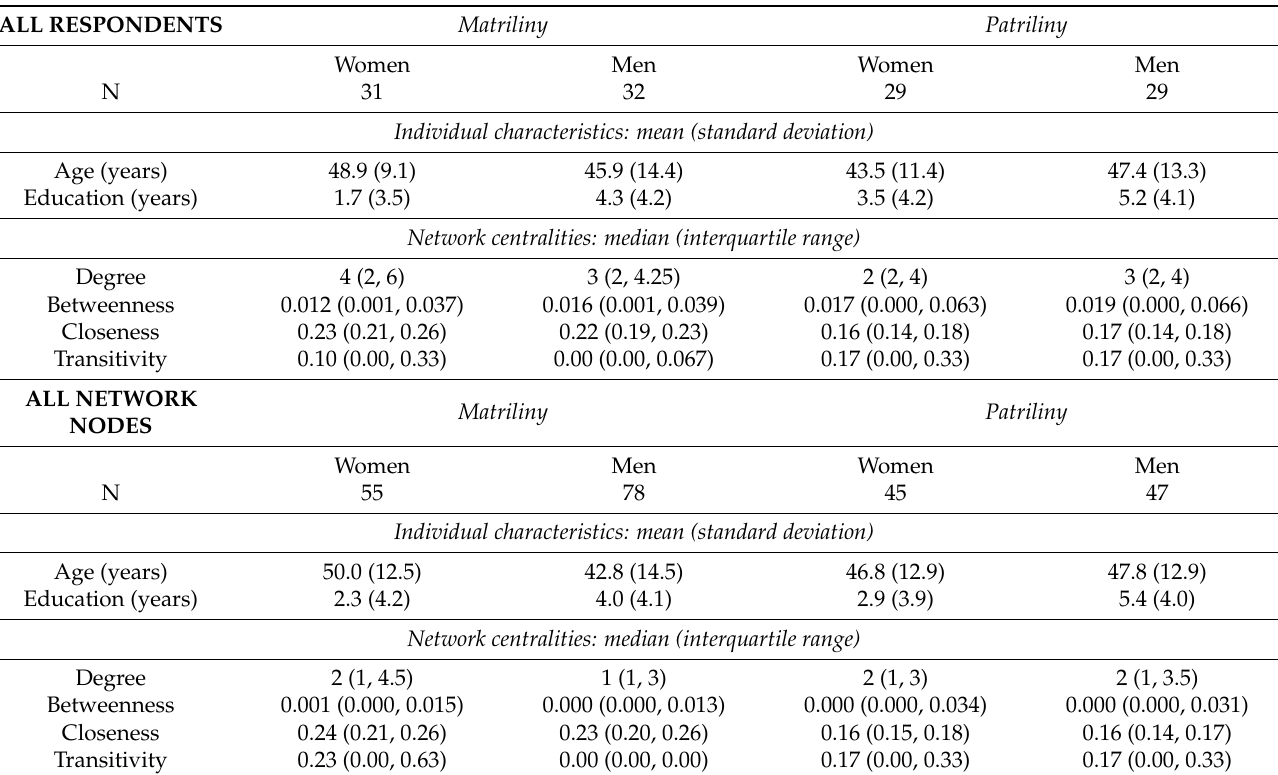
Table 1. Sample characteristics.